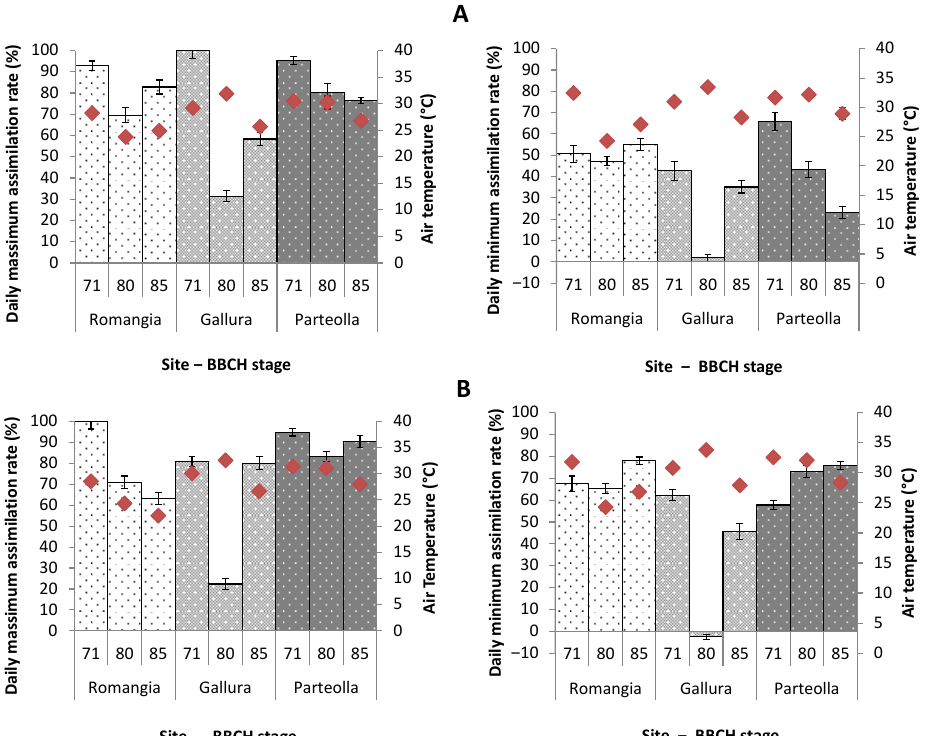
Figure 4. Daily maximum and minimum assimilation rates (histograms) and air temperature (red rhombus) at mid-morning and midday respectively, in Vermentino ( A ) and Cannonau ( B ), during pea sized berries (BBCH 71), cluster closure (BBCH 80) and mid-ripening (BBCH 85) stages 2019, in each site under clear sky condition. Values are the mean ± standard error.